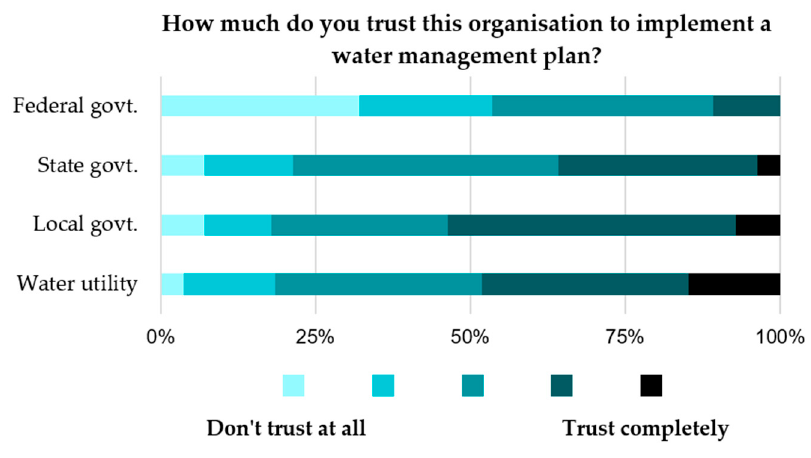
Figure 5. Community champions rating of organizational trust for implementing a water management plan.